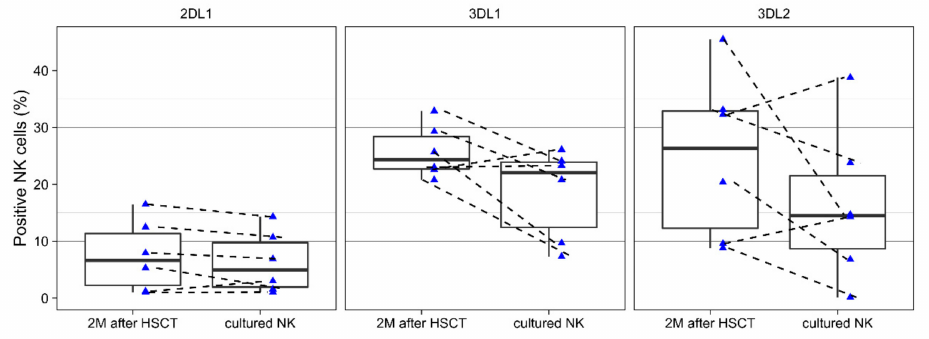
Figure 6. The expression of KIRs before (pink) and after (blue) ex vivo activation (n = 6). NK cells were isolated after HSCT and cultured for 18 days. The expression of iKIRs was estimated by flow cytometry. The cellular activation procedure did not cause significant changes in iKIR expression. No di ff erences were statistically